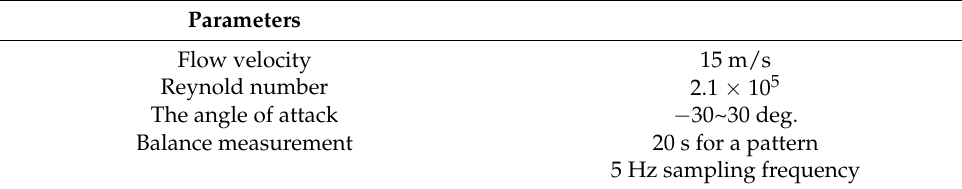
Figure 4. Meshes used for numerical calculations: ( a ) computational domain; ( b ) overview of grid; ( c ) grid distribution around the baseline model; ( d ) grid distribution around the 0.75 c stagger model.